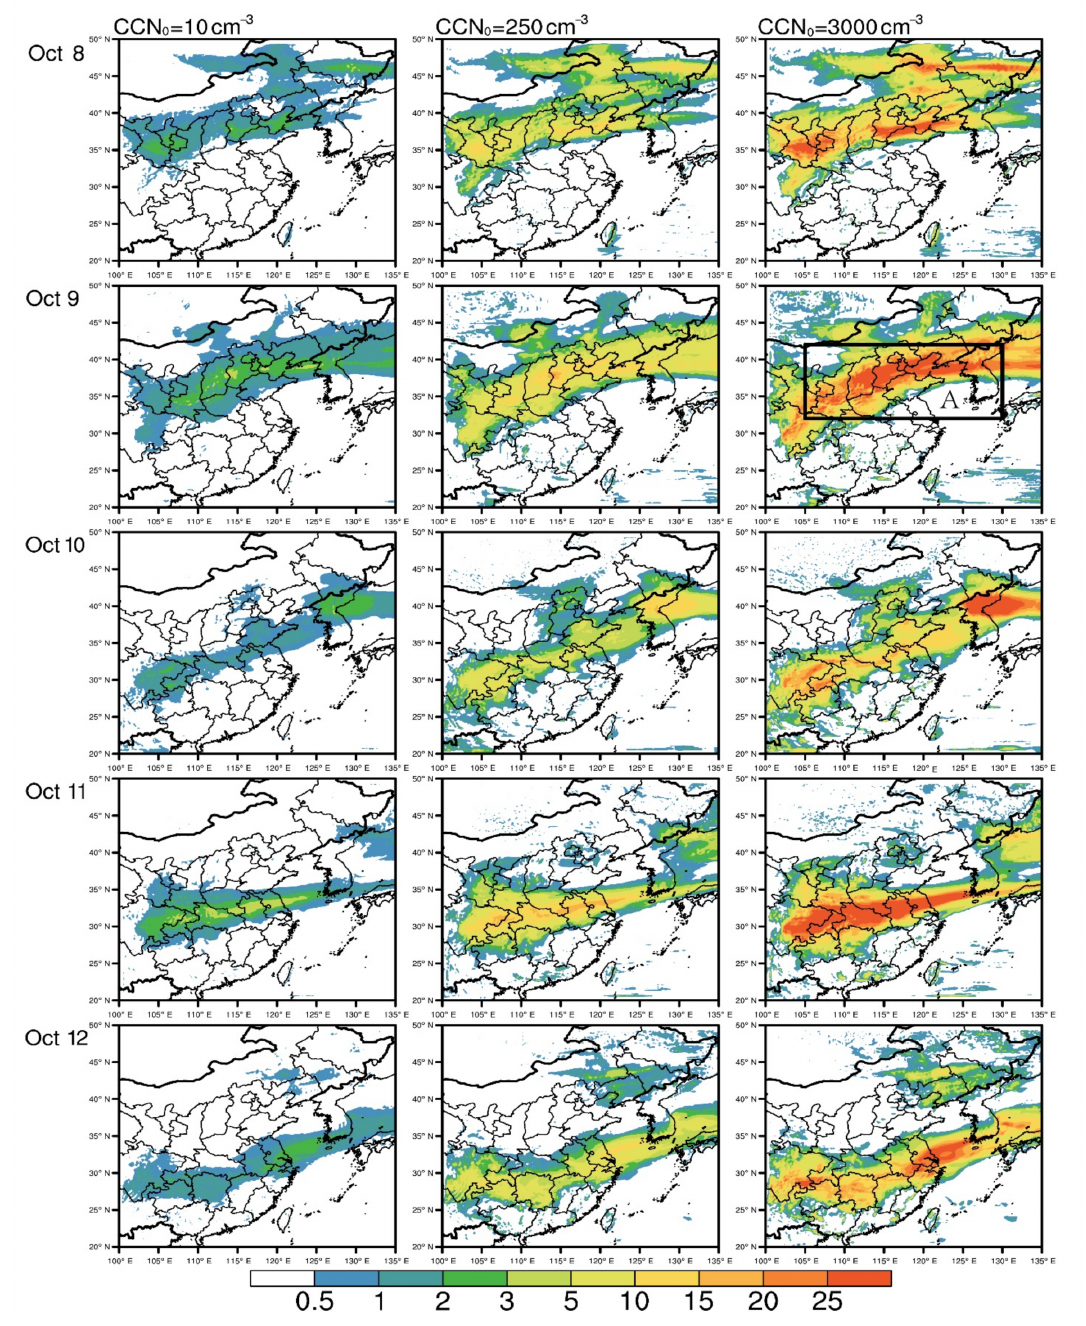
Figure 6. Daily averaged COD by model from 8 to 12 October (left: CCN 0 = 10 cm − 3 , mid: CCN 0 = 250 cm − 3 , right: CCN 0 = 3000 cm − 3